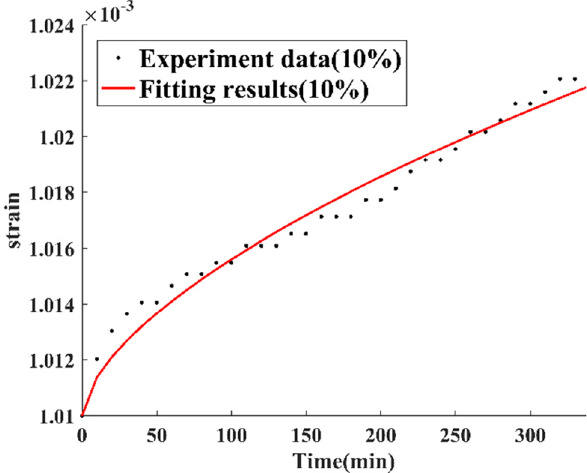
Figure 12: Fitting results based on the fractional de fi ned Maxwell model and 10% stress level.